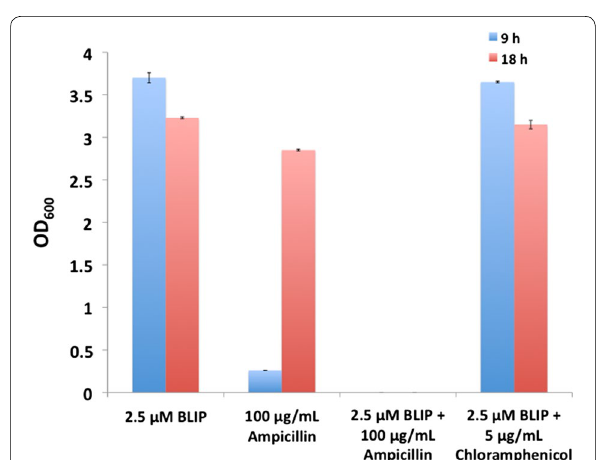
Fig. 5 Antimicrobial effect of BLIP with ampicillin on β‑lactamase‑ producing B. subtilis . A strain of B. subtilis haboring pYCL18 was culti‑ vated in LB broth at 37 °C with shaking at 280 rpm in the presence of: (1) 2.5 μM BLIP; (2) 100 μg/mL ampicillin; (3) 2.5 μM BLIP and 100 μg/ mL ampicillin; and (4) 2.5 μM BLIP and 5 μg/mL chloramphenicol. The bacterial growth of the cultures was monitored by OD 600 at time intervals of 9 and 18 h. The experiment was repeated in